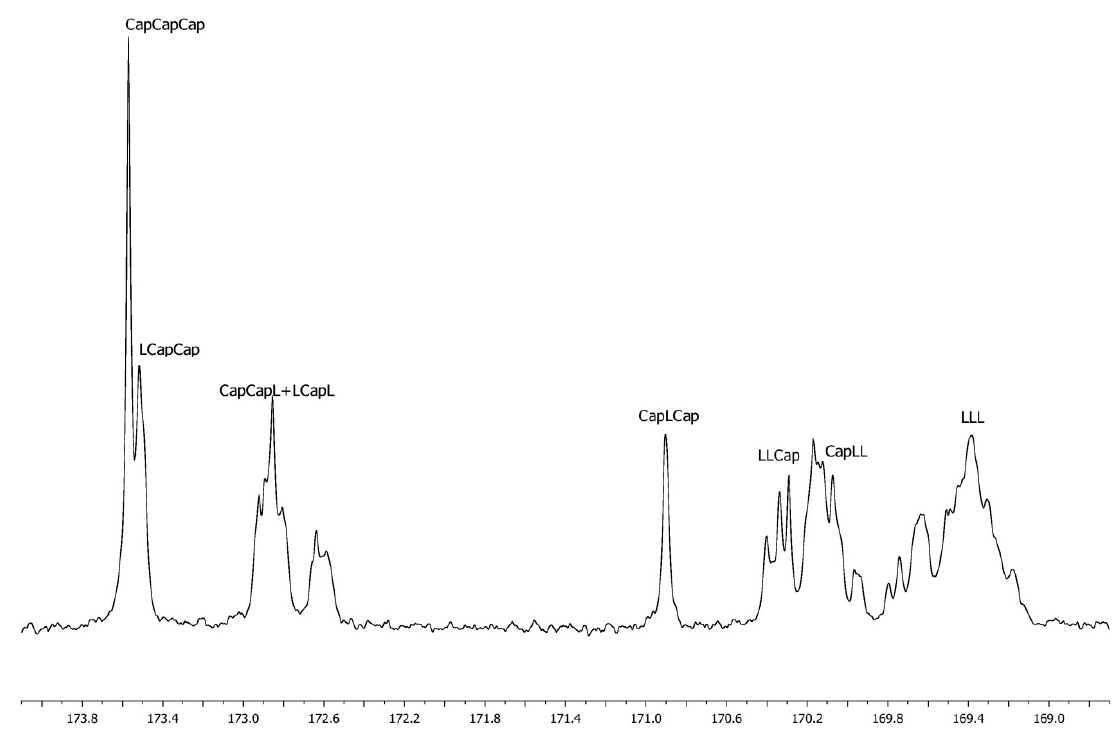
Figure 2. Typical 13 C NMR spectrum of the obtained copolymers (carbonyl region).